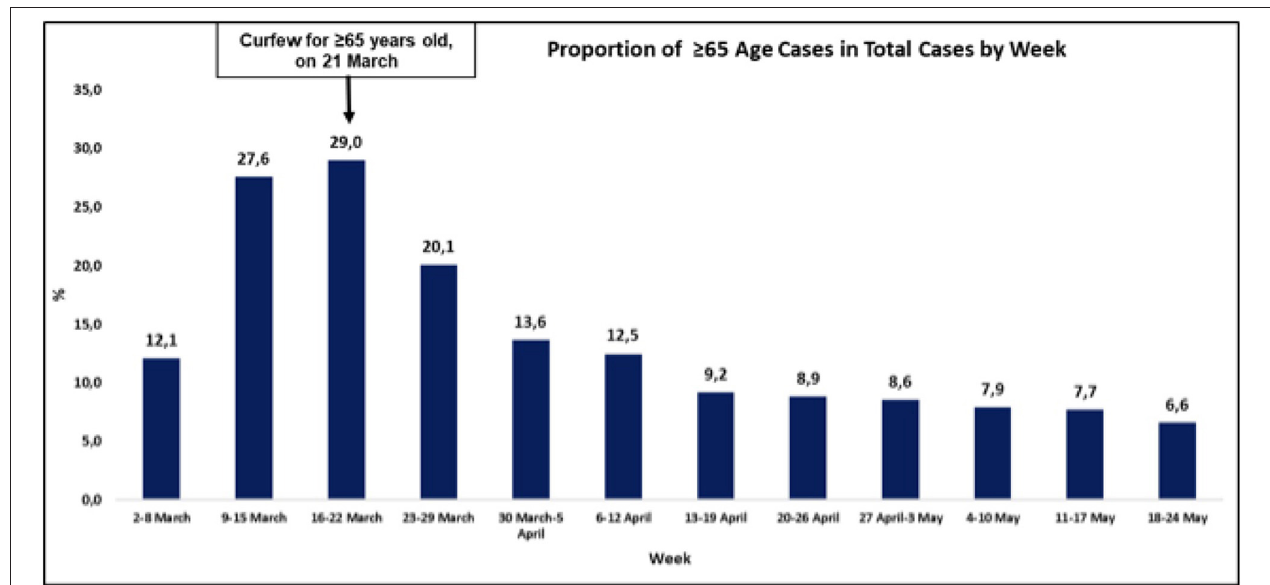
FIGURE 2 | The incidence of new cases of SARS-CoV-2 in the elderly. Source: Daily reporting from the Directorate General for Health Information Systems, Ministry of Health, Turkey